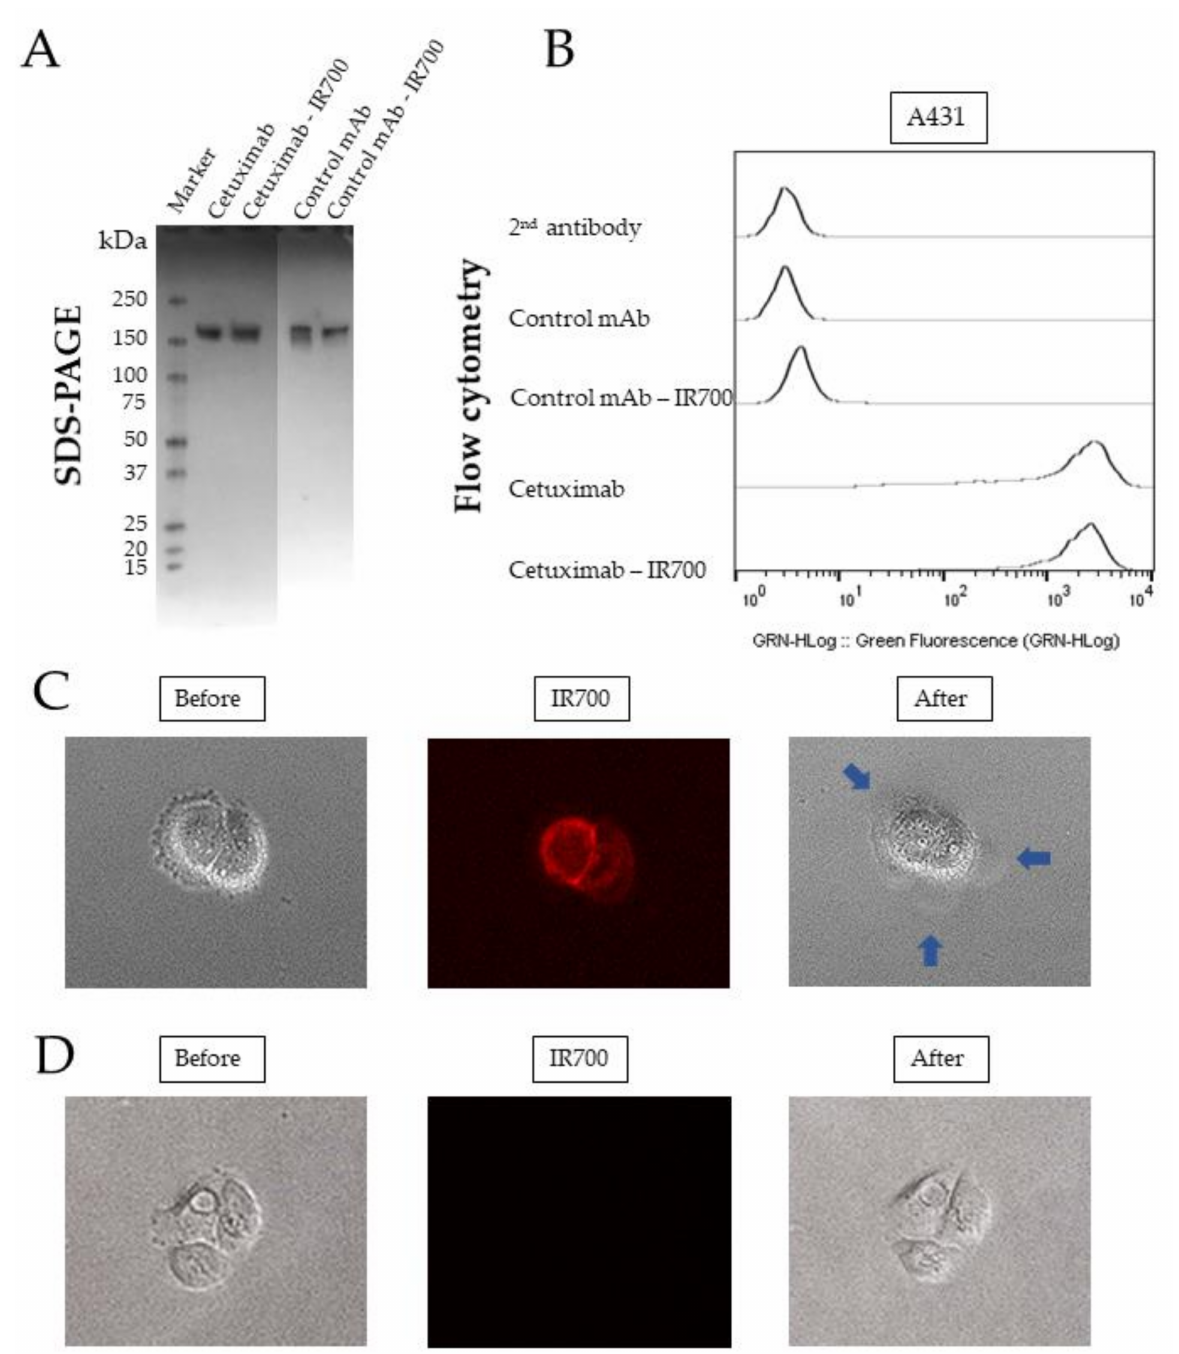
Figure 1. Quality control of Cetuximab-IR700. ( A ) Non-reducing SDS-PAGE analysis of Cet-IR700 and Control mAb-IR700. Marker: molecular mass marker. ( B ) Conjugation of various monoclonal antibodies to A431 cells. Cet-IR700 and cetuximab showed a high binding ability to EGFR protein. ( C ) Morphological changes of cells after photoimmunotherapy (PIT) with Cet-IR700. The EGFR- specific localization of Cet-IR700 in A431 cells was confirmed by fluorescence microscopy. Ruptured A431 cells were observed under the microscope after 20 J/cm 2 of laser irradiation. Blue arrows indicate cells that have ruptured and formed blisters. ( D ) Morphological changes of cells after PIT with Control mAb-IR700. There was no morphological change of A431 cells before and after PIT, and Control mAb-IR700 could not be observed by fluorescence